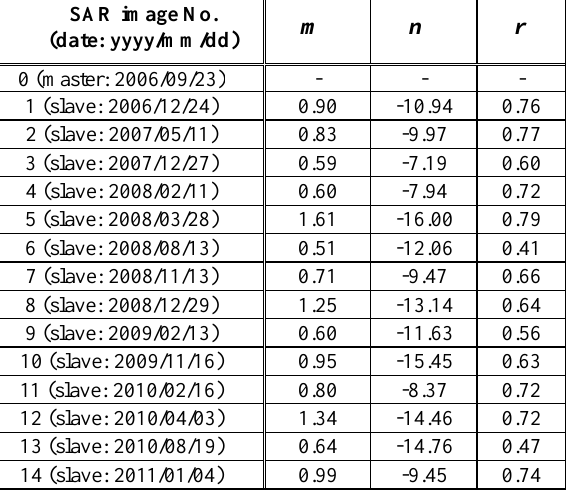
Table 1. SAR images used for the analysis. “ m ” and “ n ” denote gain and offset derived by applying a linear regression model (Equation (20)), respectively. “ r ” denotes correlation coefficient by applying Equation (20). SAR image